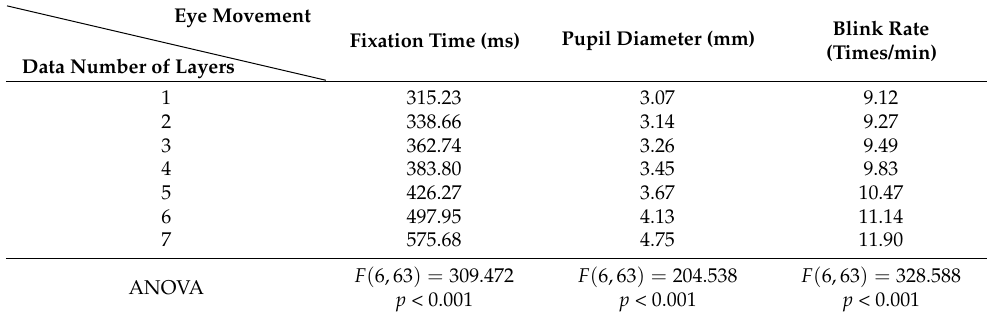
Data Number Table 12. The average eye movement data of subjects completing tasks under different information layers.